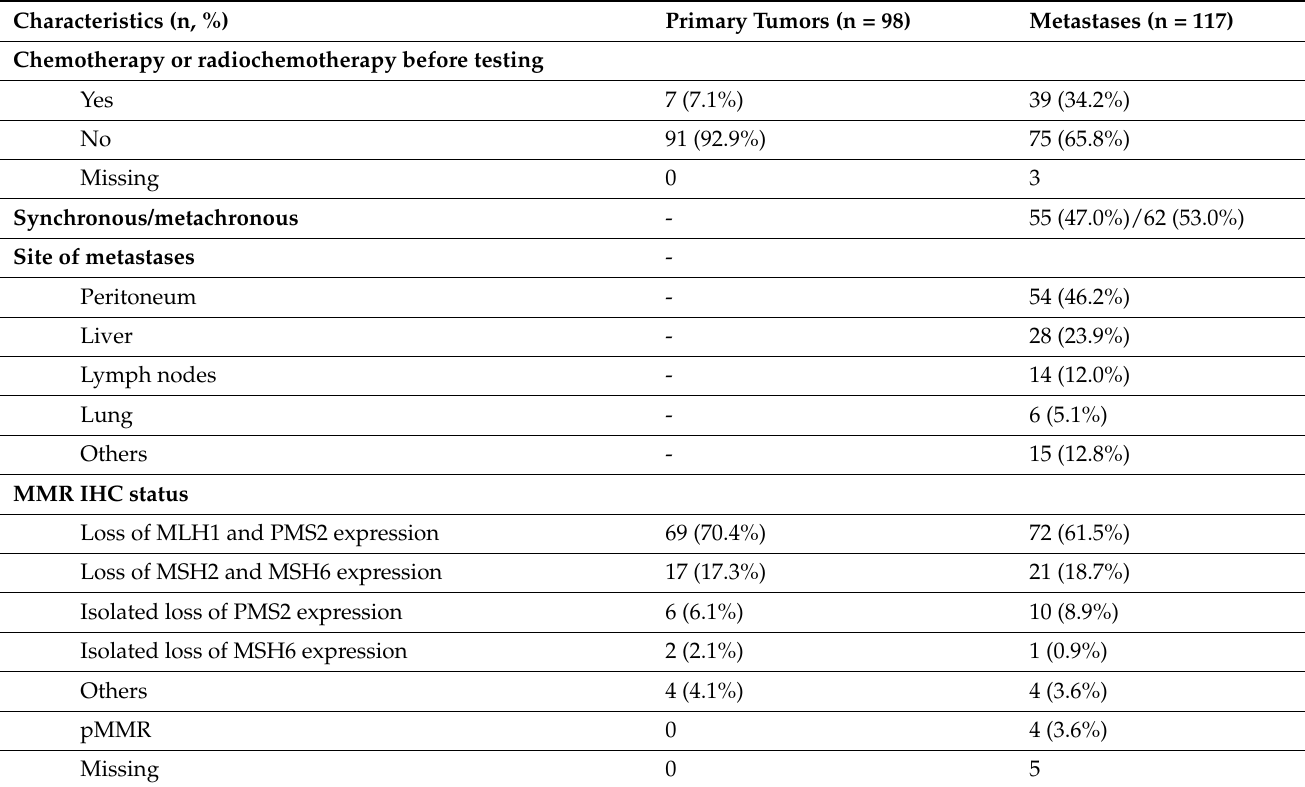
Table 2. MMR immunochemistry and MSI tests on primary tumors and paired